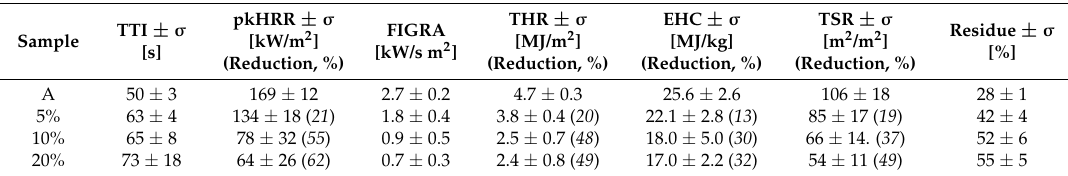
Figure 6. Histograms of the cone calorimetry data for untreated and treated fabrics: ( a ) time to ignition; ( b ) peak of heat release rate; ( c ) total heat release and ( d ) total smoke release. Table 2. Cone calorimetry data of untreated and treated acrylic fabrics.